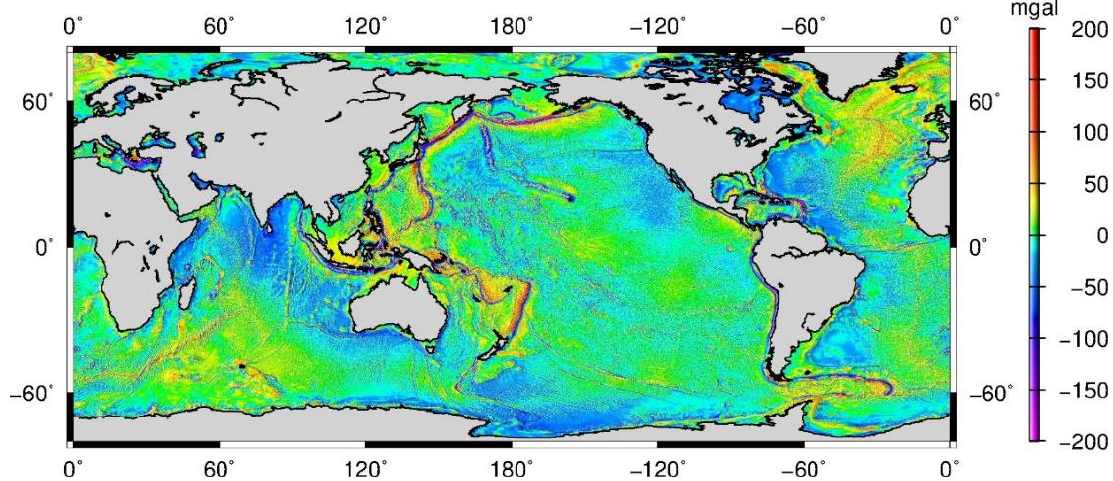
Figure 12. Global gravity anomaly model NSOAS22.